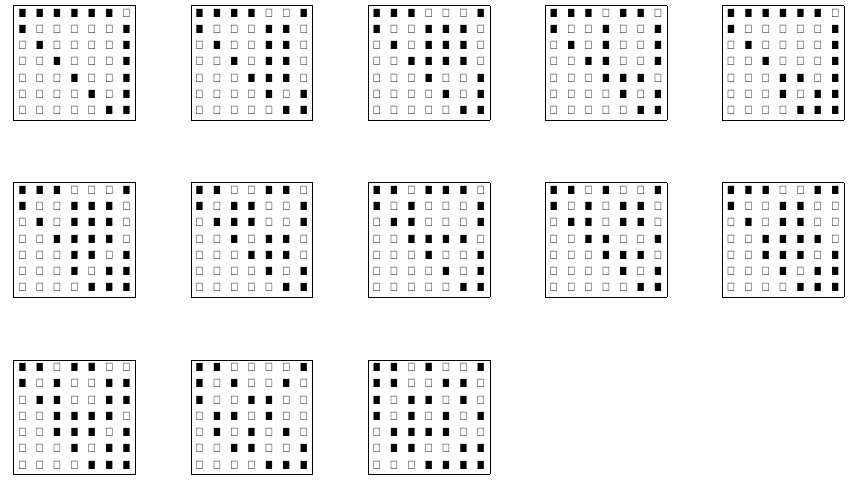
Table 19: Minimal matrix representations of all thirteen acute 0/1 -simplices in I 7